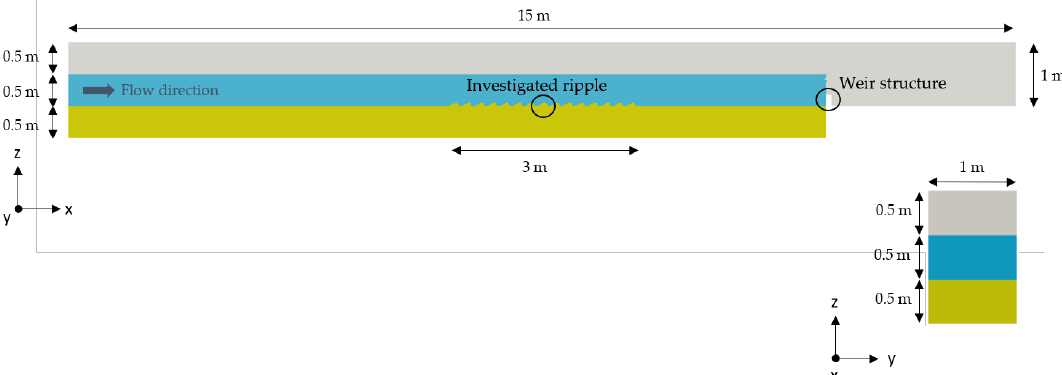
Figure 1. Model geometry and initial condition for the water level (sediment: yellow, water: blue, air: gray); top: front view, bottom right: cross-section.